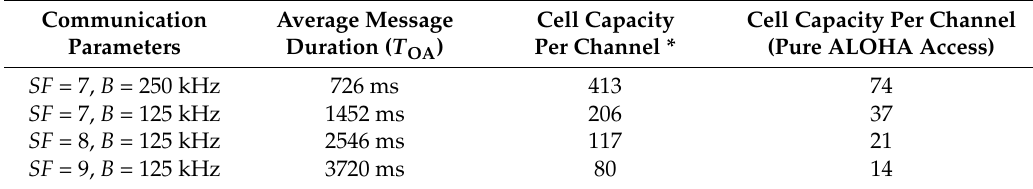
Table 6. Capacity of a single LoRa base station (reported as number of allowed motes per channel) corresponding to one uplink message of 49 B, and eleven consecutive downlink messages of 67 B each, with a Coding Rate value CR of 4/5. EU regional specifications have been considered.